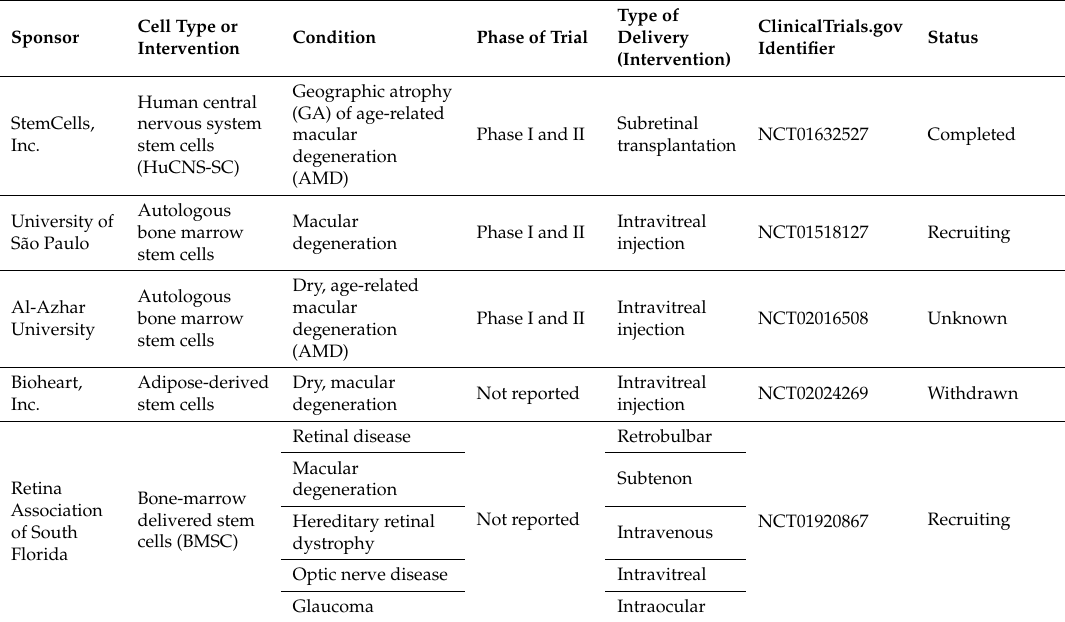
Table 2. Stem cell-based cell types for inherited and non-inherited macular degenerations. Study type: Interventional. Last updated 25 October